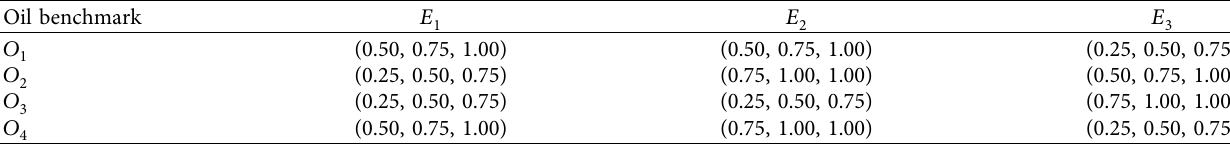
Table 6: Fuzzy weight of criteria.